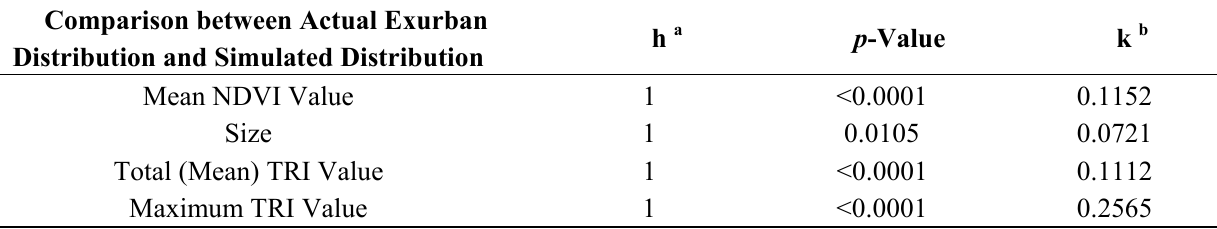
Table 3. Comparison of the actual exurban house distribution to the simulated distribution for each visual quality metric: greenness, viewshed size, and ruggedness (Two-sample K-S test).